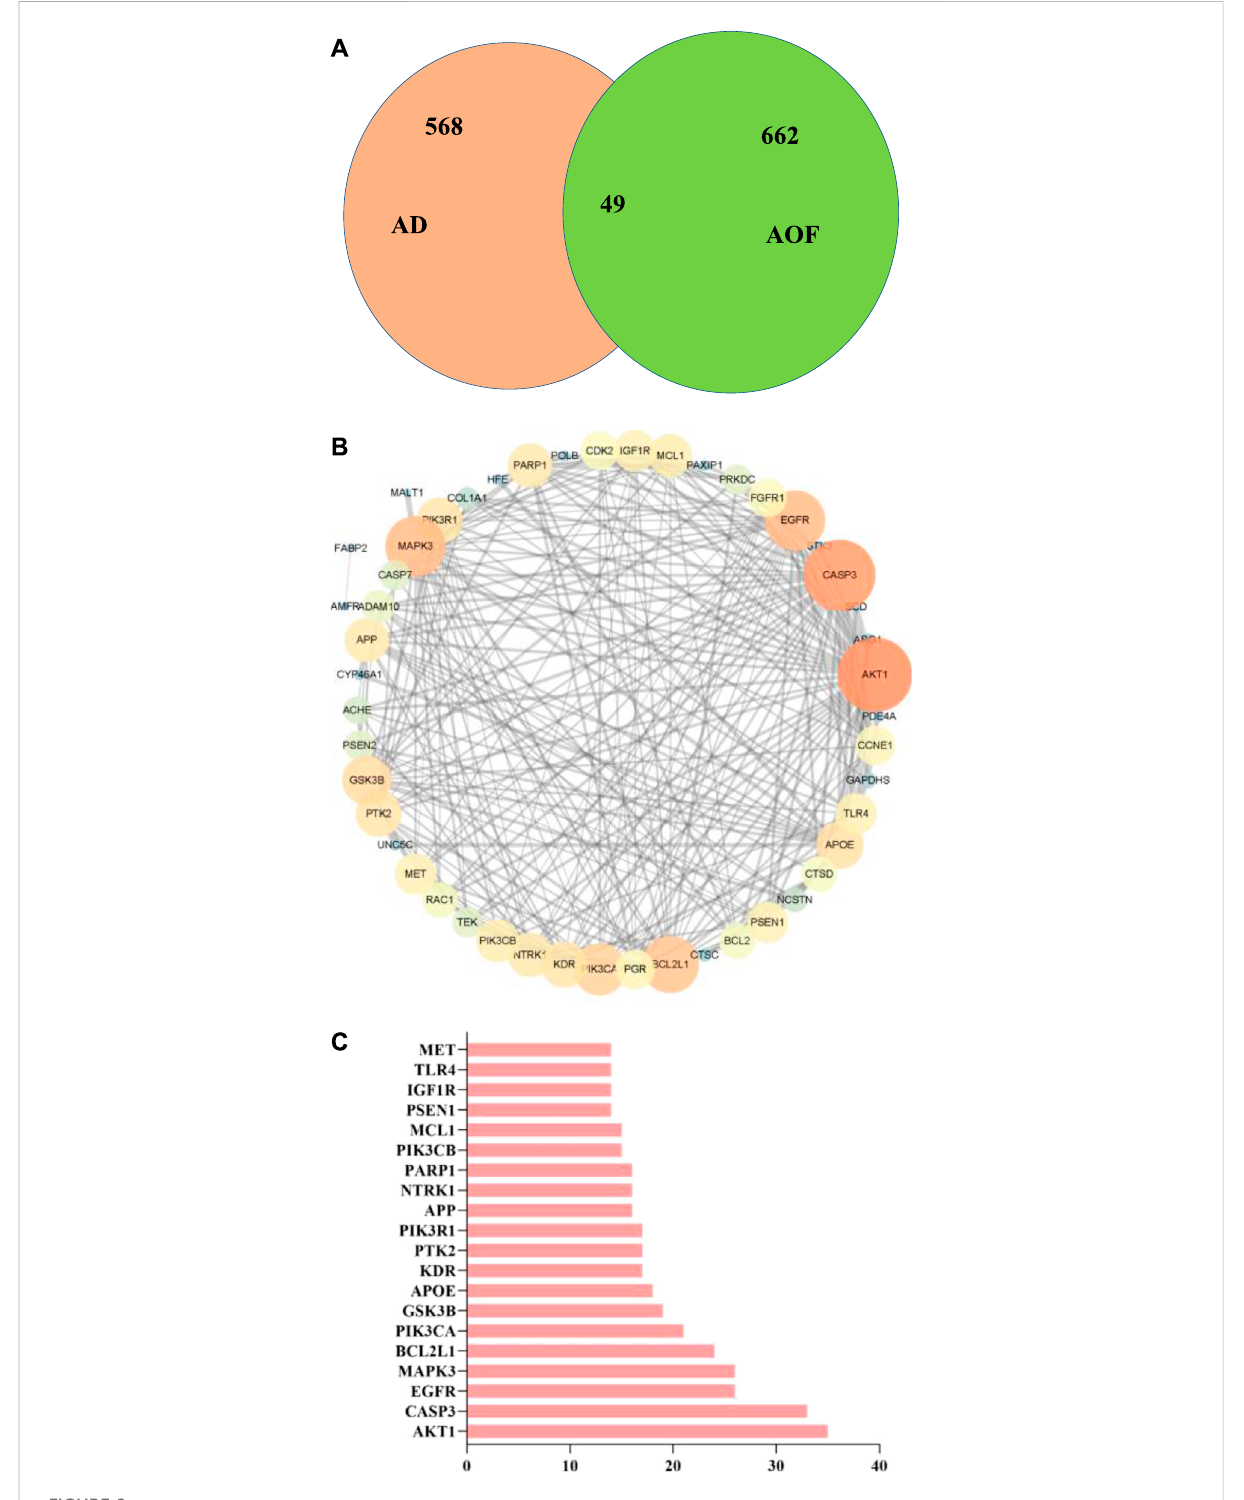
FIGURE 2 Overlapped targets screen (A) Venn diagram describing target distribution of AOF and AD (B) The protein-protein interaction (PPI) network of AOF target for the treatment of AD. The colors of the nodes are illustrated from orange to blue in descending order of degree values (C) The top 20 genes in the PPI network were selected based on the